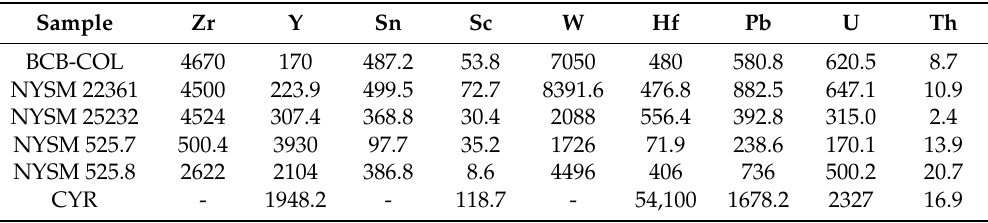
Table 2. Trace elements in columbite and “cyrtolite” by LA-ICP-MS and LA-MC-ICP-MS (U) (ppm) (five analyses on each crystal).